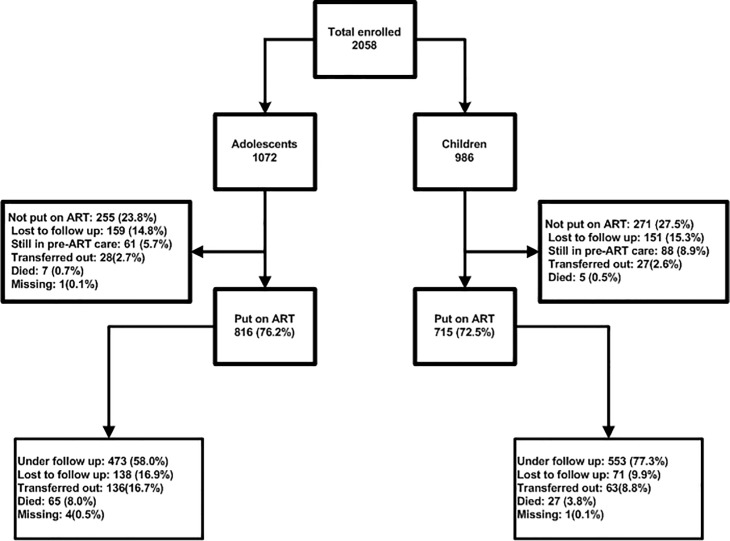
Cohort profile and follow-up status of patients.